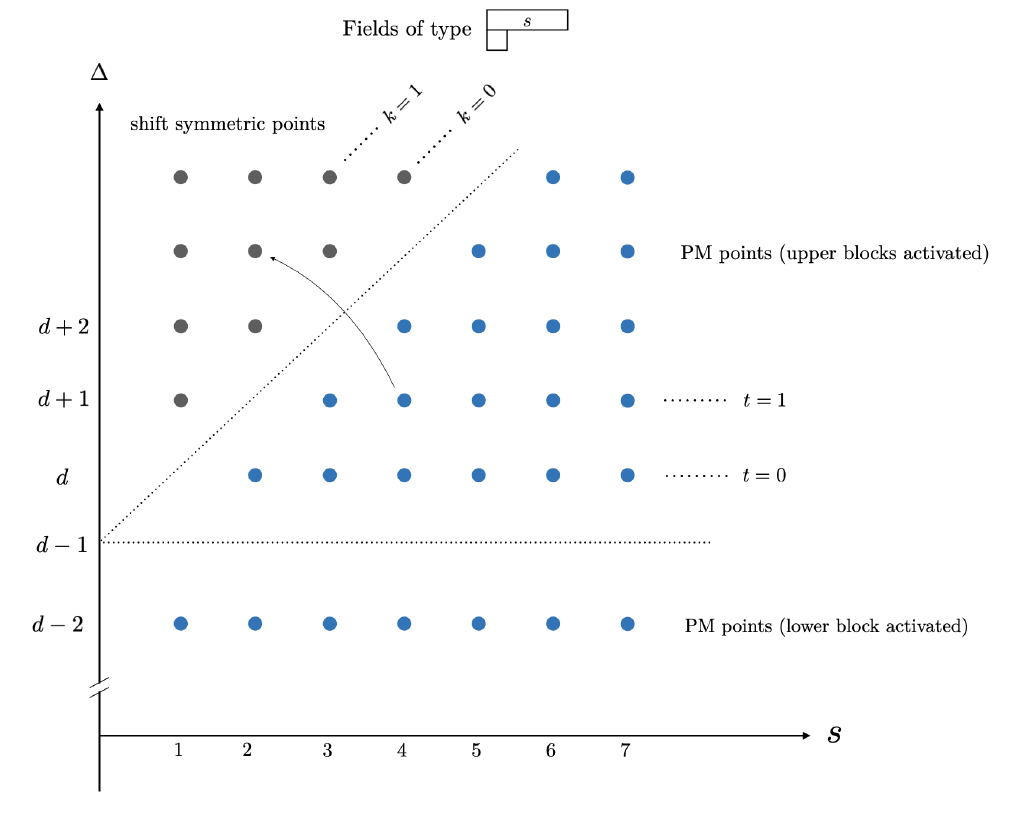
Figure 2 . Fields of symmetry type [ s, 1] in the conformal dimension ∆ vs. s plane, for the values of the positive root ∆ . The masses are given by ˜ m 2 L 2 = ∆(∆ − d ) − s − 1 . Blue dots are PM points, + black dots are shift symmetric points. The shift symmetric points are the longitudinal modes of the PM points where the upper row is activated. The shift point field corresponding to a given such PM point is found by reflecting about the line ∆ = s + d − 1 , as illustrated by the curved arrow. The AdS unitarity bound for each s coincides with the uppermost PM